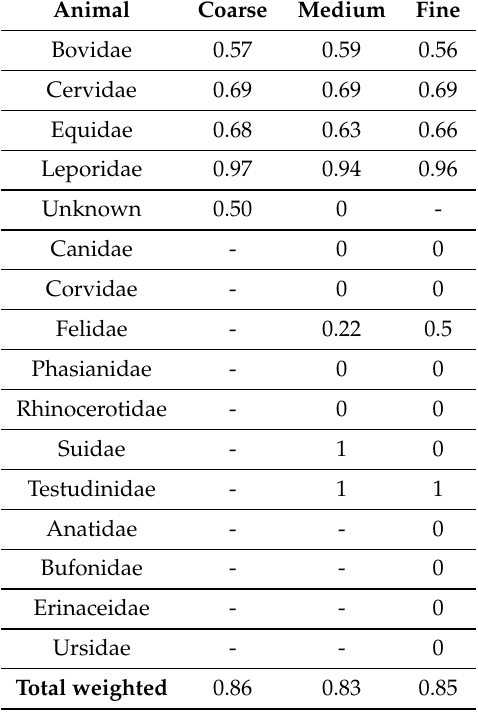
Table 3. F1-score of the random forest in the different